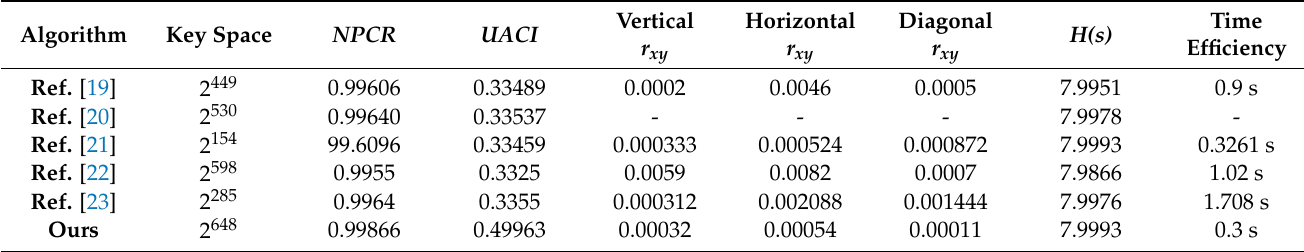
Table 4. Cryptosystem metrics comparison with other